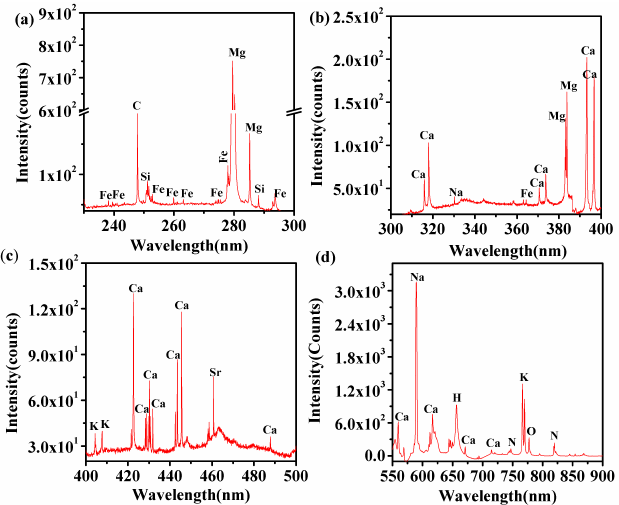
Figure 2. LIBS spectra of t. dioica leaves for different spectral regions. ( a ) 230 to 300nm, ( b ) 300 to 400nm, ( c ) 400 to 500nm, and ( d ) 550 to